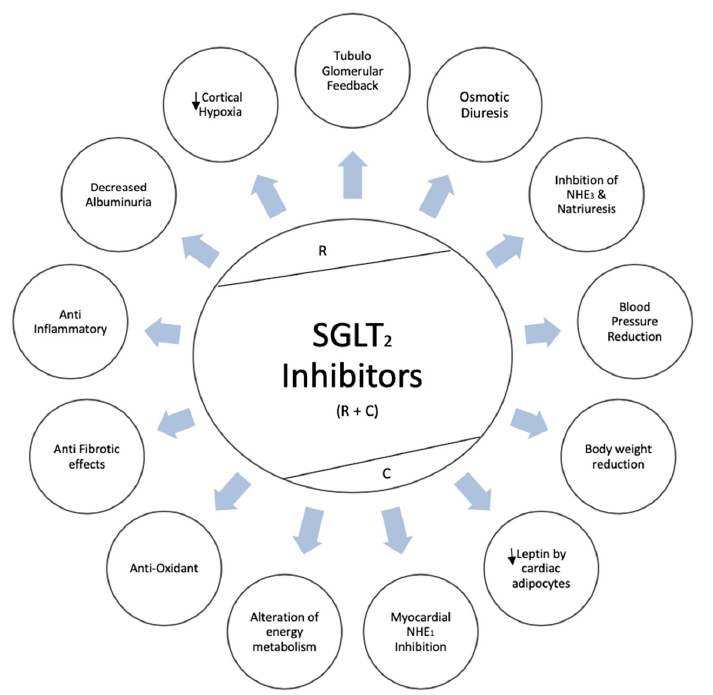
Figure 1. Renoprotective and cardioprotective mechanisms of sodium-glucose co-transporter 2 (SGLT2) inhibitors. R = renoprotective; C–predominantly cardioprotective; R + C- renoprotective and cardioprotective; - decreased.